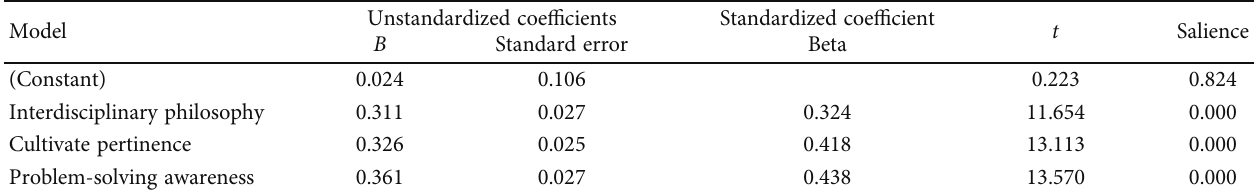
Table 3: Coe ffi cients of the training target fi tting equation.